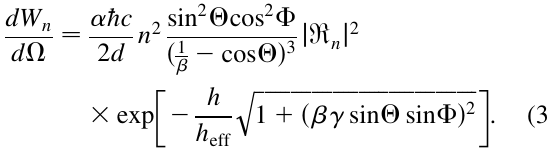
FIG. 1. (Color) Scheme of the Smith-Purcell radiation genera- tion from the volume gratings: (a) lamellar grating; (b) grating with vacuum